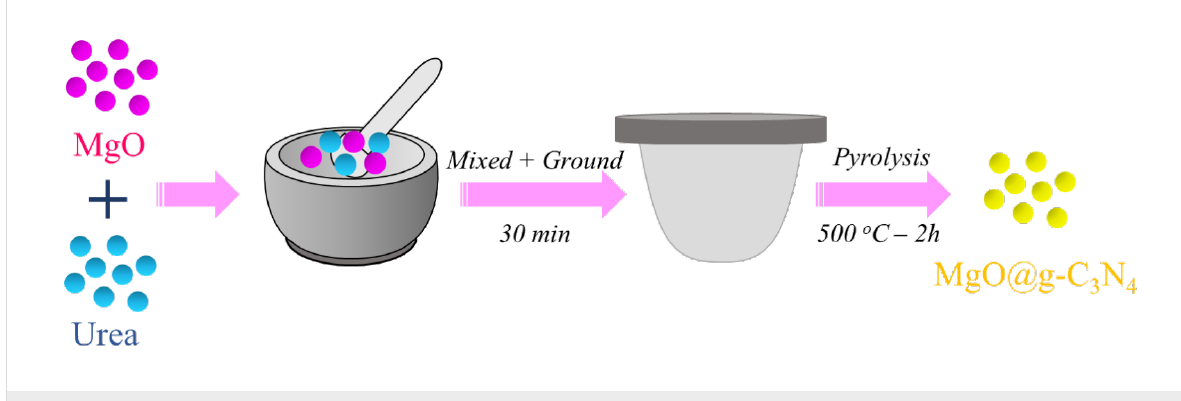
Figure 1: Schematic diagram of pyrolysis synthesis process for MgO@g-C 3 N 4 heterojunctions.